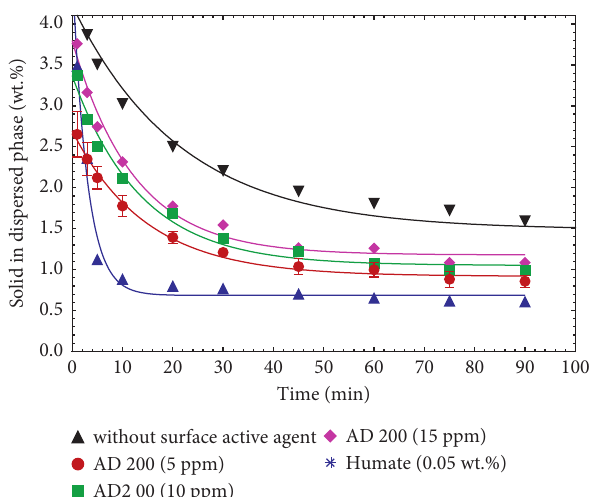
Figure 3: Stability of the dispersed phase (% solid) of iron ore fines versus time at pH 8 with different concentrations of AD 200 and humate and without surface-active agent. Data points represent minimum duplicate experiment. The solid lines represent equation (1). Table 3: Values of the parameters of equation (1) for beneficiation of 10 wt. % slurry of slime. Experiment System Stability of suspension in 10 wt. % slurry of slime (Figure 2)